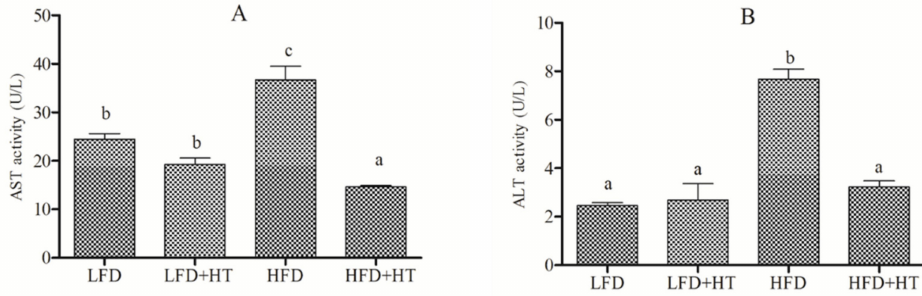
Figure 1. Plasma AST ( A ) and ALT ( B ) activities of blunt snout bream fed with experimental diets. Bars with different letters are significantly different ( p < 0.05).